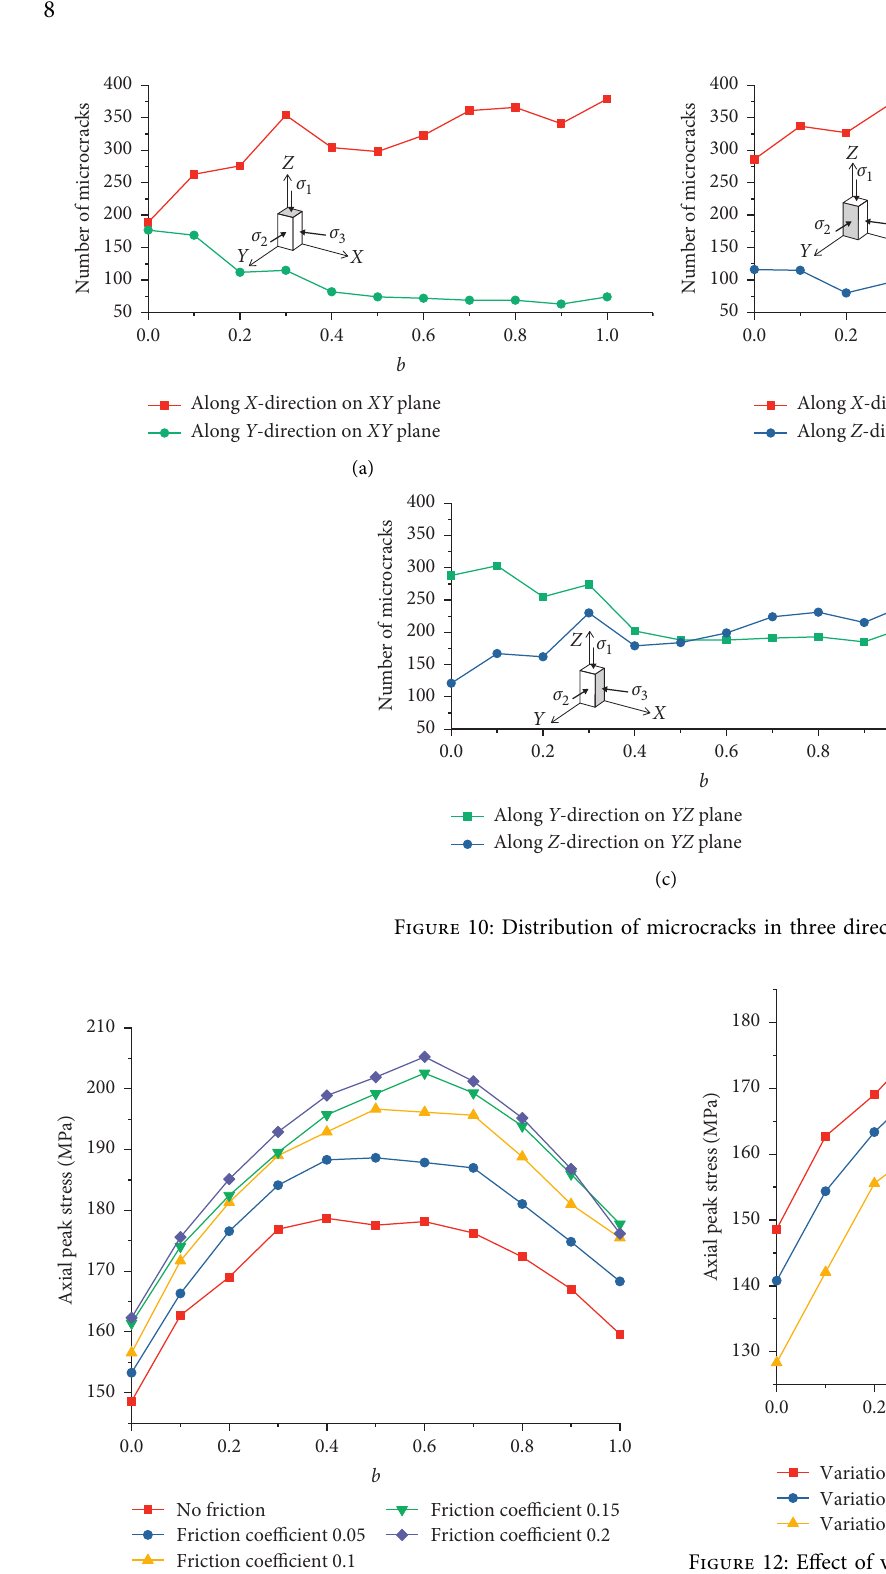
Figure 11: Effect of end friction on the axial peak stress.